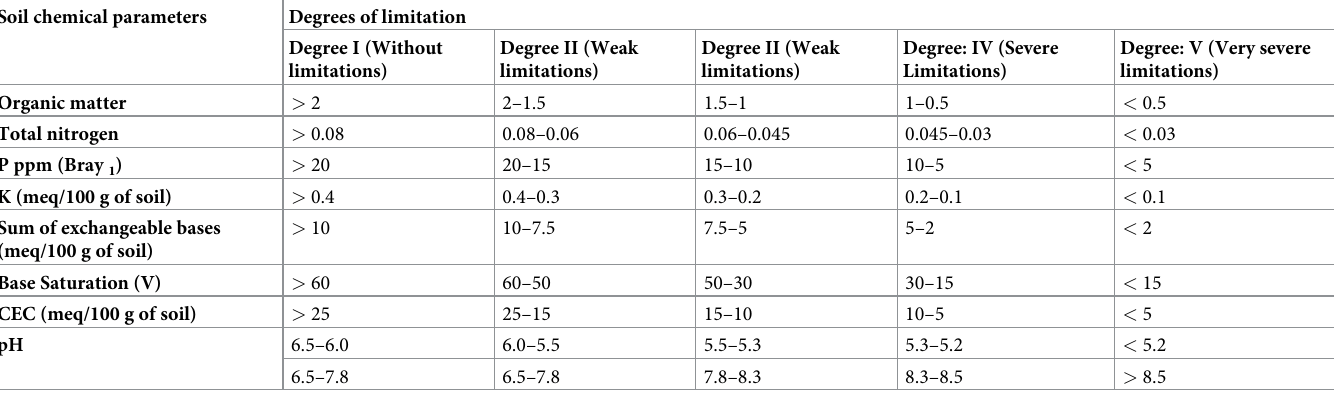
Table 1. Criteria for assessing the degrees of limitation of soil chemical parameters